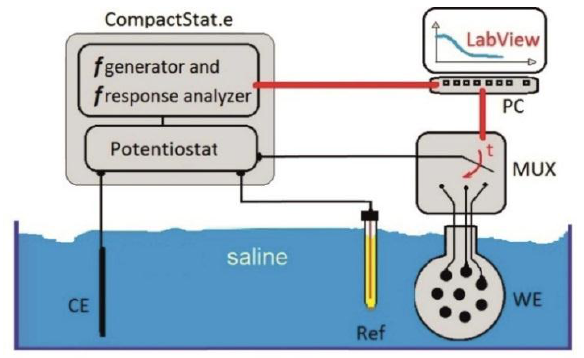
Figure 4. EIS test set-up with LabView-controlled multiplexer (MUX); CE stands